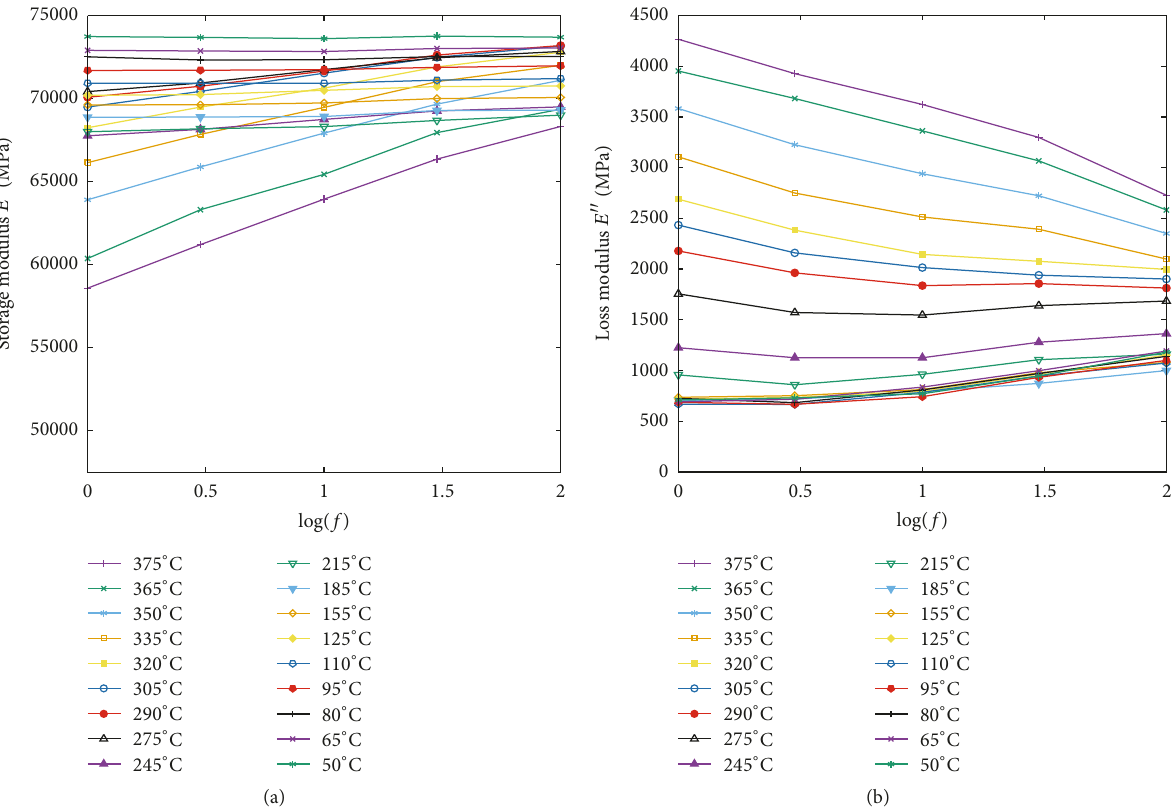
Figure 3: Isothermal storage modulus 𝐸 󸀠 (a) and loss modulus 𝐸 󸀠󸀠 (b) versus logarithm of the frequency 𝑓 from DMA tests on AA 2024-T3 at frequencies ranging from 1 to 100Hz and from 50 to 375 ∘ C.